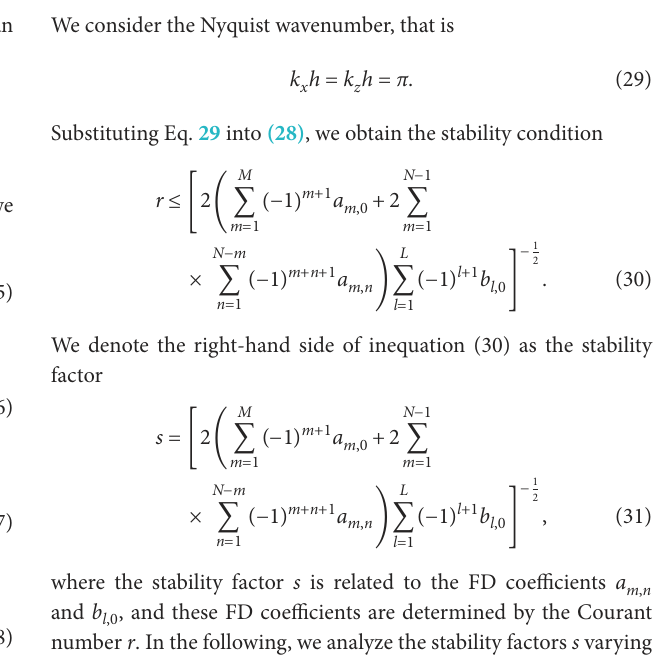
satisfies the widest range of the wavenumber ( kh ) , which can mitigate the spatial dispersion error